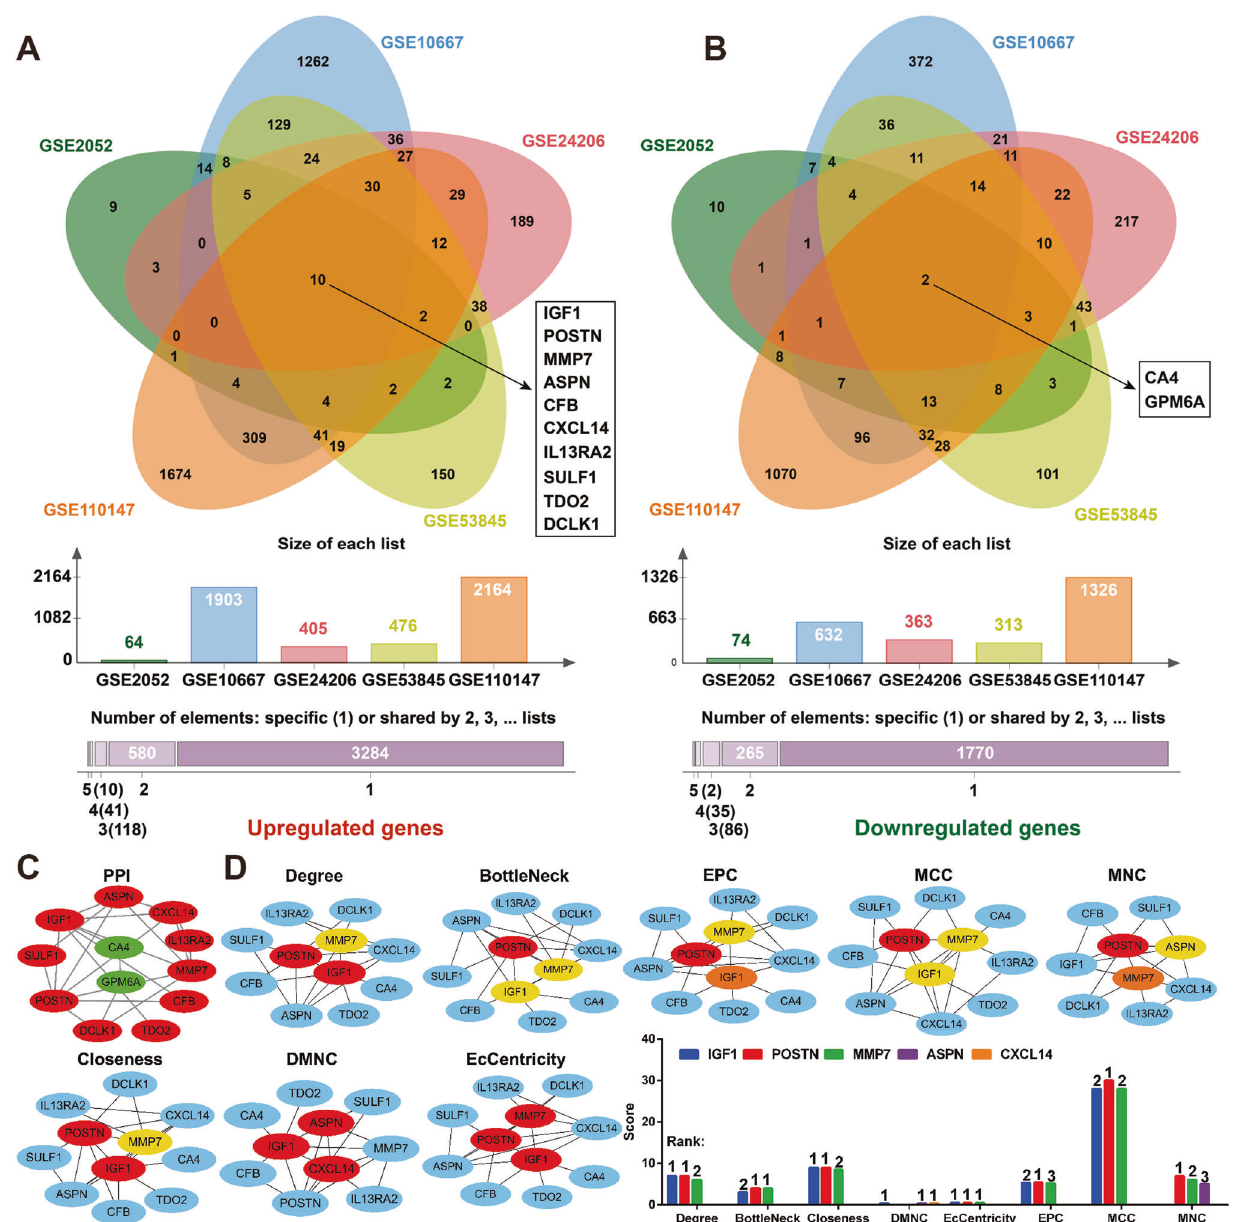
Fig. 1 IGF1 identi fi ed as a hub gene in PF. A , B The up- and down-regulated intersection genes among the 5 datasets were selected by jvenn tool. C The protein – protein interaction (PPI) network analysis of the up- and down-regulated intersection genes was performed by STRING and Cytoscape software. D The hub genes were predicted by the plug-in cytoHubba of Cytoscape software and the top three nodes ranked by MCC, DMNC, MNC, Degree, EPC, BottleNeck, EcCentricity and assays. In vivo, compared with the control group, the protein levels of p-IGF1R(Tyr1135/1136)/IGF1R, COL-1, COL-3, and α -SMA were increased in the CD-NPs group but decreased after PPP interven- tion; lung coef fi cients had a similar trend, and both had a dose- dependency of PPP (Fig. 3E – G). The results suggest that CD-NPs induce PF by activating IGF1/IGF1R signaling.